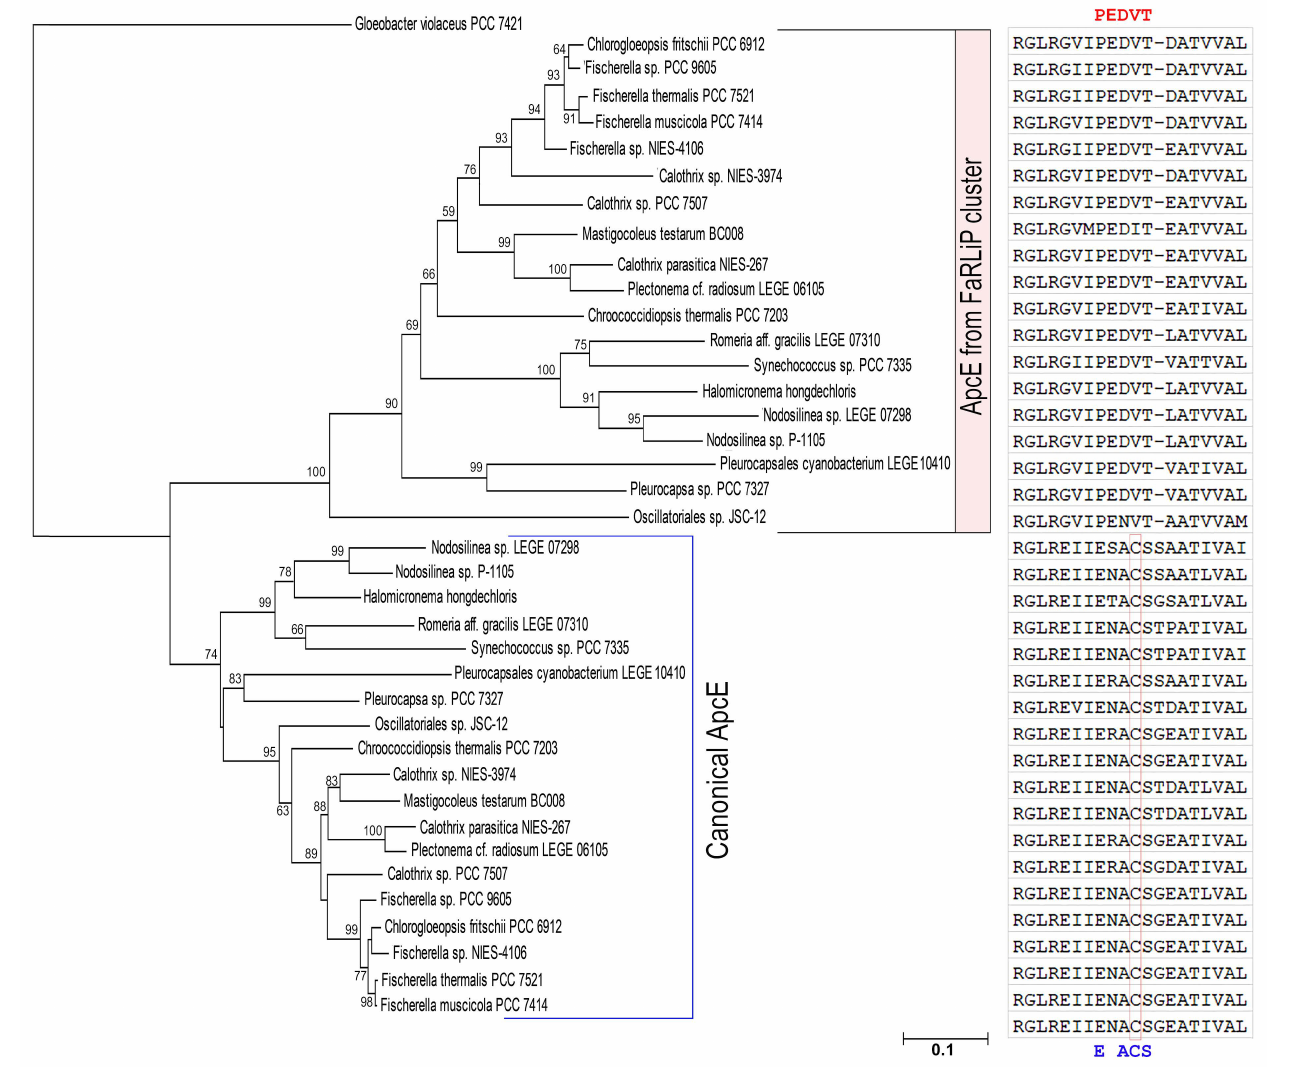
Figure 6. Neighbor-Joining phylogeny and alignment of conserved phycobiliprotein region of ApcEs from CA6-capable cyanobacteria. The conserved Cys sites from canonical ApcE proteins are highlighted in a red framed box. The conserved motif PEDVT in ApcE from FaRLiP cluster are highlighted in red. The conserved motif ExACS in canonical ApcE are highlighted in blue. The ApcE sequence accessions are listed in Table